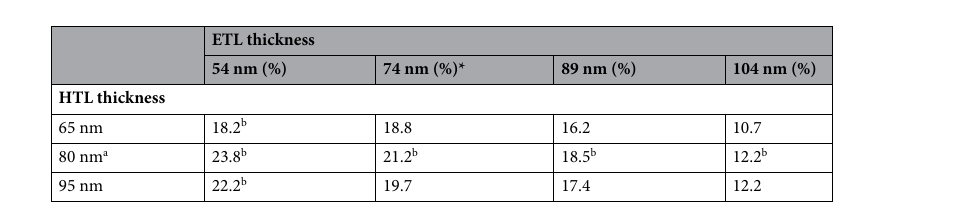
Table 1. Summary of peak EQE for different ETL and HTL thickness. a Reference thickness calculated using refractive index for constructive interference. b Devices presented in Fig.